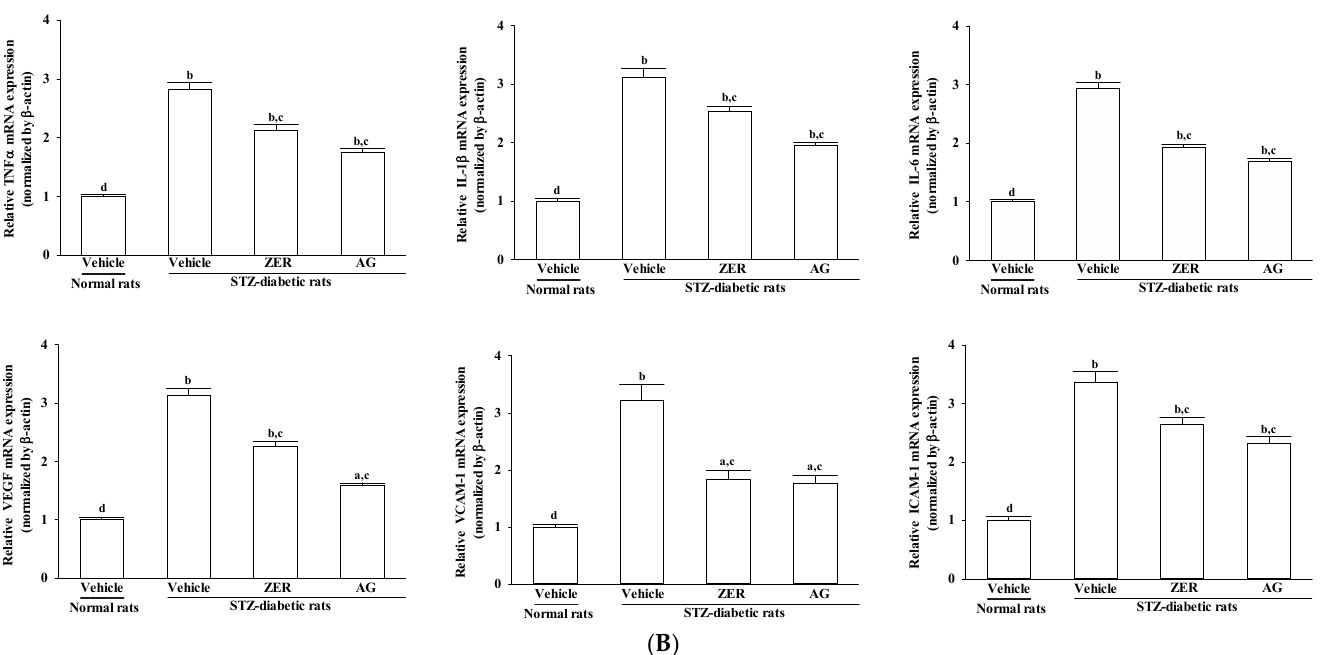
Figure 3. Effects of the treatments on the ( A ) protein and ( B ) mRNA levels of inflammatory cytokines and chemokines in retina of rats. STZ ‐ diabetic rats were administered 40 mg/kg/day ZER, or 50 mg/kg AG by oral gavage once daily for three months. Another group of STZ ‐ diabetic rats and normal rats were administered the same volume of vehicle used to prepare the test medication solutions. Data are mean ± SEM from eight rats per group, and the experiments were repeated independently at least three times with similar results. a p < 0.05 and b p < 0.01 compared to vehicle ‐ treated normal rats, respectively; c p < 0.05 and d p < 0.01 compared to the values of vehicle ‐ treated STZ ‐ diabetic rats, respectively